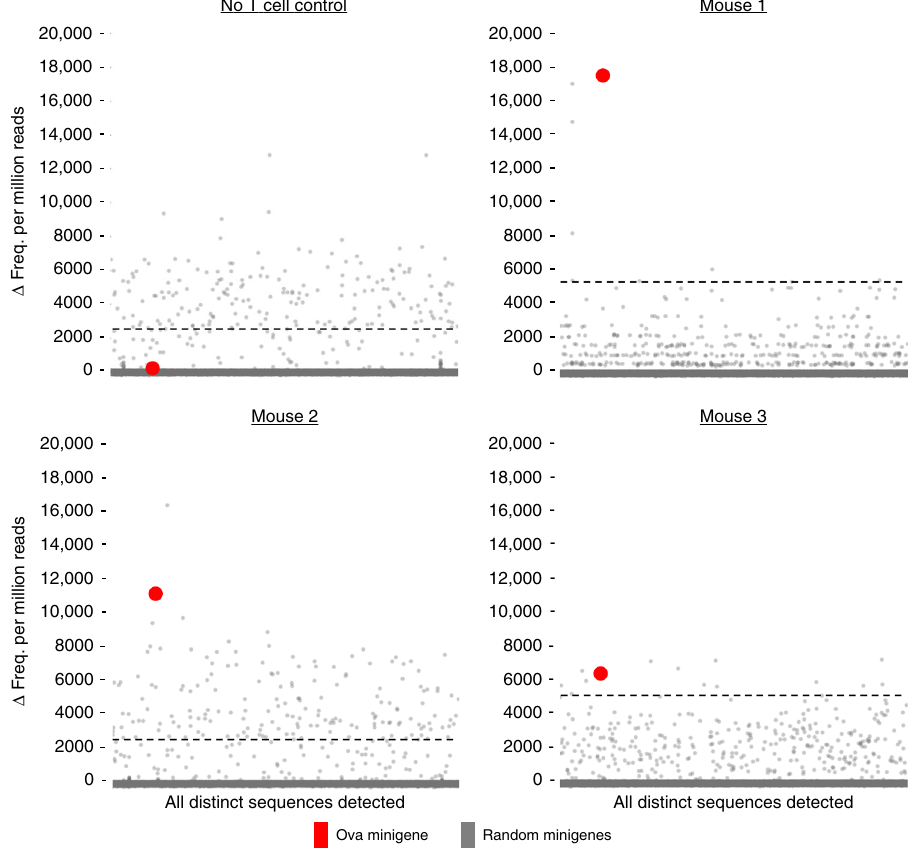
Fig. 6 FRET-shift/amplicon sequencing using tumor-in fi ltrating T cells as input effectors. B16F10-Ova tumor masses were engrafted into wild-type C57BL/ 6 mice and boosted by vaccination with Ova prior to isolation of tumor-in fi ltrating CD8 + T cells by FACS, further expanded by stimulation with plate-bound anti-CD3/28, and co-cultured with random minigene library cells spiked with Ova minigene-expressing cells at 1:10,000 abundance. Three replicate mice were prepared, and TIL samples from each were independently screened against the spiked library cell population. Limited outgrowth ex vivo of the TIL populations necessitated that co-cultures be conducted at reduced E:T ratios, ranging from 0.5:1 to 0.7:1 across the replicates (4 h length). In parallel to TIL samples, a matched negative control sample was prepared by performing FRET-shift FACS/amplicon sequencing on spiked library target cells that were not subjected to co-culture with any T cells. The Δ relative abundance of all detected minigenes are displayed for the three replicate TIL screens as well as the no-T-cell control. The dashed line represents 10 σ above the mean Δ relative abundance